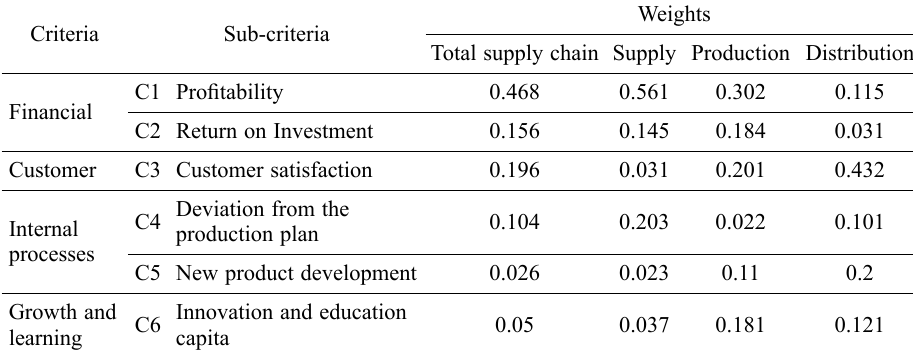
Table 4. The weights of criteria related to strategies selection from different perspectives